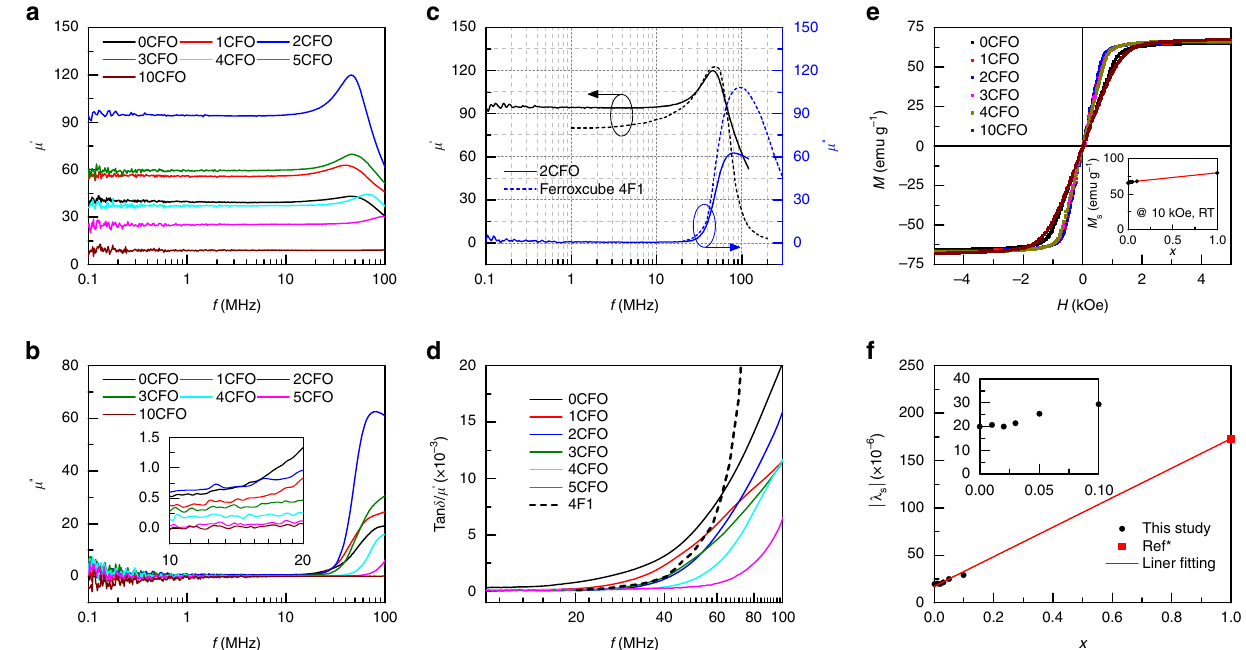
Fig. 2 Magnetic properties of NCZF-CFO materials. a Frequency dependence of the real part of permeability, μ ′ , of NCZF-100 x CFO. b Frequency dependence of the imaginary part of permeability, μ ″ , of NCZF-100 x CFO. c Permeability comparison between NCZF-2CFO and commercial high-frequency ferrite Ferroxcube 4F1. d Loss factor tan δ = μ ′ ¼ μ ′′ = ð μ ′′ Þ 2 comparison among different ferrite compositions. e Magnetization vs. magnetic fi eld loops of λ j j of NCZF-100 x CFO. λ j j ¼ 2 j j þ λ j jð Þ , where λ NCZF-100 x CFO. f Saturation magnetization λ 11 is the longitudinal magnetostriction measured when the 11 12 s s 3 strain gauge was parallel to the magnetic fi eld, and λ 12 is the transverse magnetostriction measured when the strain gauge was perpendicular to the j j for pure CFO ( x = 1) refers to prior study (Ref. 24 magnetic fi eld. The data point of λ s